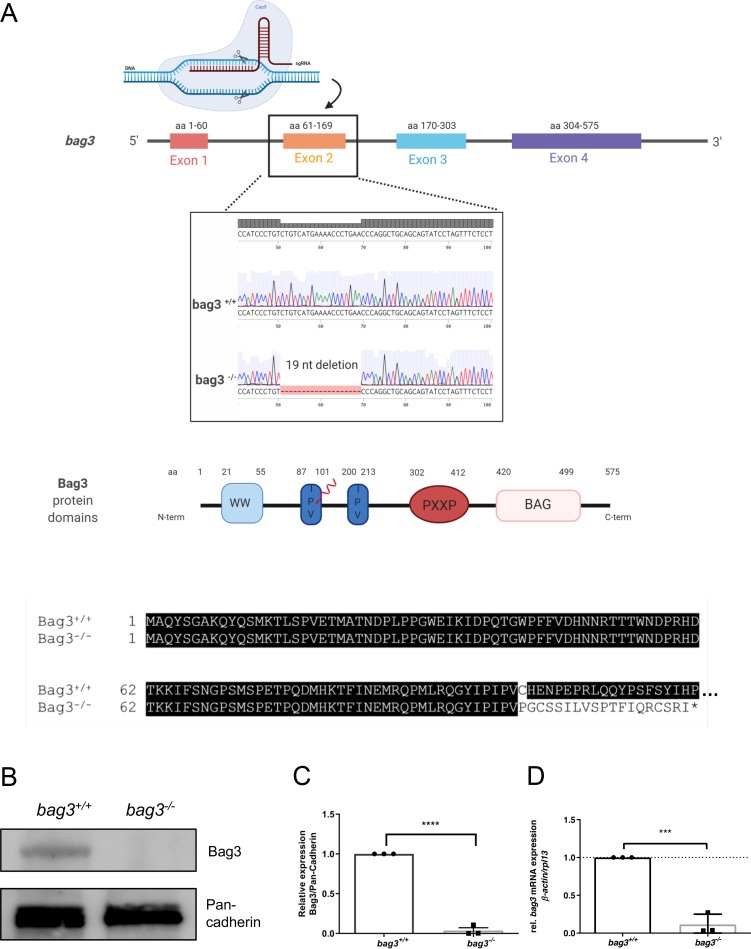
Generation of zebrafish bag3 knockout by CRISPR/Cas9 gene editing.(A) Structure of the zebrafish bag3 gene and protein. Exon 2 is the target for the CRISPR/Cas9 gene editing in zebrafish bag3. The CRISPR/Cas9-induced mutation (19 bp deletion) in bag3 is shown in bag3 mutant DNA sequencing chromatogram. The 19 nucleotides deletion in bag3-/- leads to a frame shift, the introduction of a premature stop codon and thereby the premature termination of Bag3 translation, as demonstrated by the alignment of the Bag3-/- and Bag3+/+ aminoacid sequences (only partial aminoacid sequence shown) (B-C) Immunoblot analysis of 72 hpf bag3+/+ embryo protein lysates compared to lysates obtained from bag3-/- clutchmates with antibody against zebrafish Bag3. The figure shows one representative immunoblot from three independent experiments (N = 3, mean ± SD, P<0.0001 determined using two-tailed t-test). (D) Quantitative real-time PCR of bag3+/+ and bag3-/- embryos at 72 hpf shows significant downregulation of bag3 mRNA levels in bag3-/- embryos (N = 3, mean ± SD, P = 0.0004 determined using two-tailed t-test).